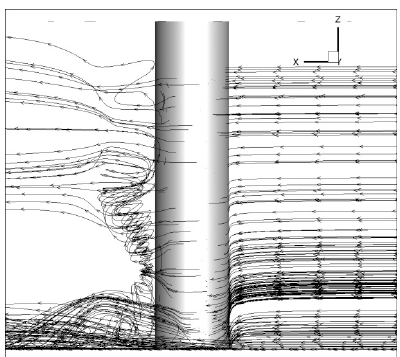
Figure 8. Streamlines of tidal current when passing the monopile foundation.